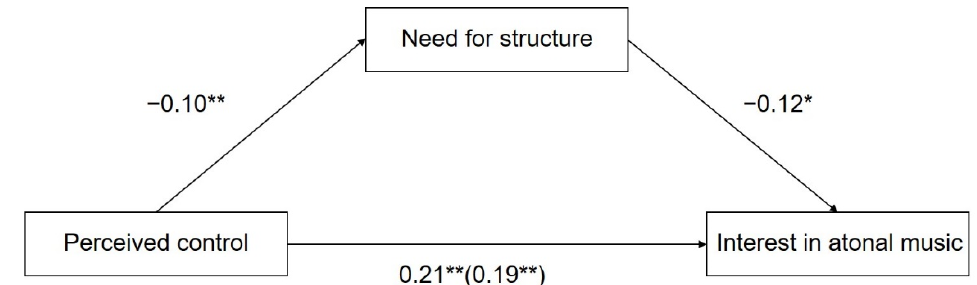
Figure 2. Mediation model of the need for structure in the relationship between perceived control and interest in atonal music. Path values are the path coefficients with standard errors. * p < 0.05. ** p < 0.01. Table 3. Mediating effect test of need for